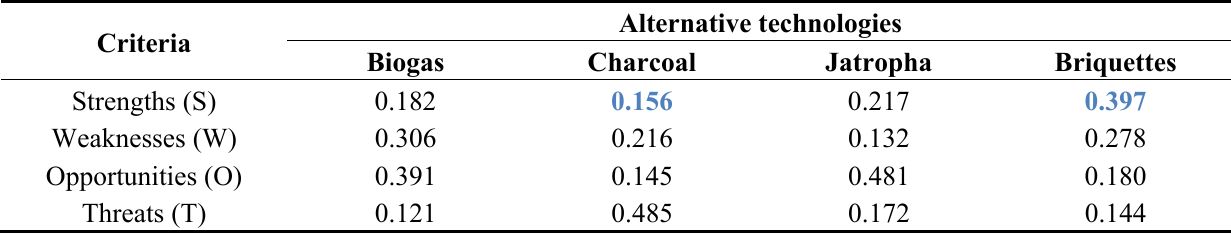
Table A2. Multi-criteria decision matrix of the current study.